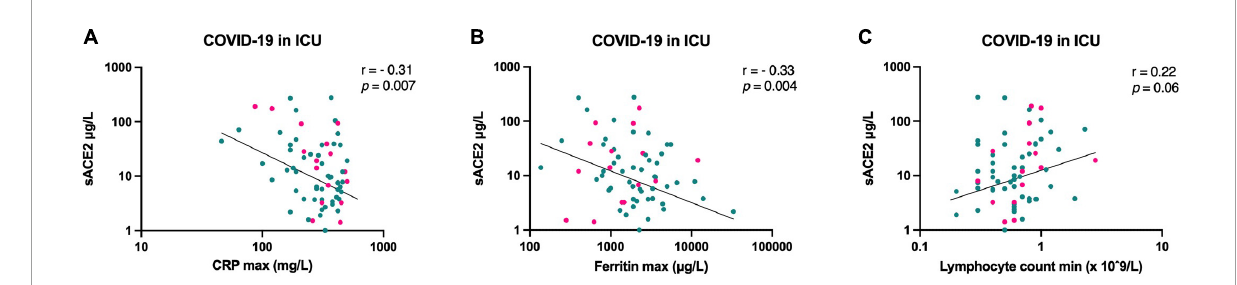
FIGURE5 Correlation between sACE2 concentrations ( µ g/L) at hospital admission and maximum C-reactive protein (CRP, mg/L) (A) , maximum ferritin ( µ g/L) (B) , and minimum lymphocyte count (x 10 9 /L) (C) , respectively, for patients with COVID-19 in the intensive care unit (ICU). Men = green, women =